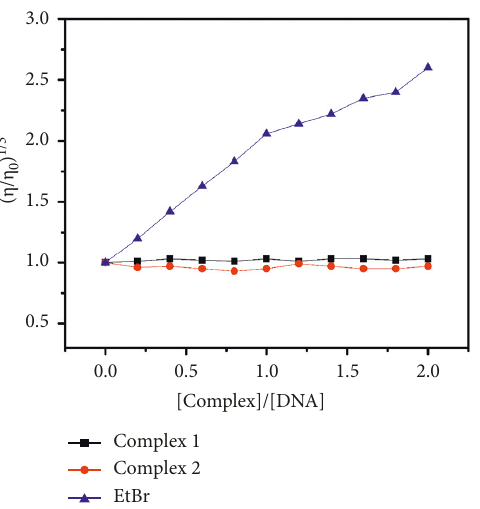
Figure 9: Effect of increasing amounts of EtBr and complexes 1 and 2 (20–200 µ M) on the relative viscosities of CT-DNA (100 µ M) in Tris-HCl buffer at room temperature.